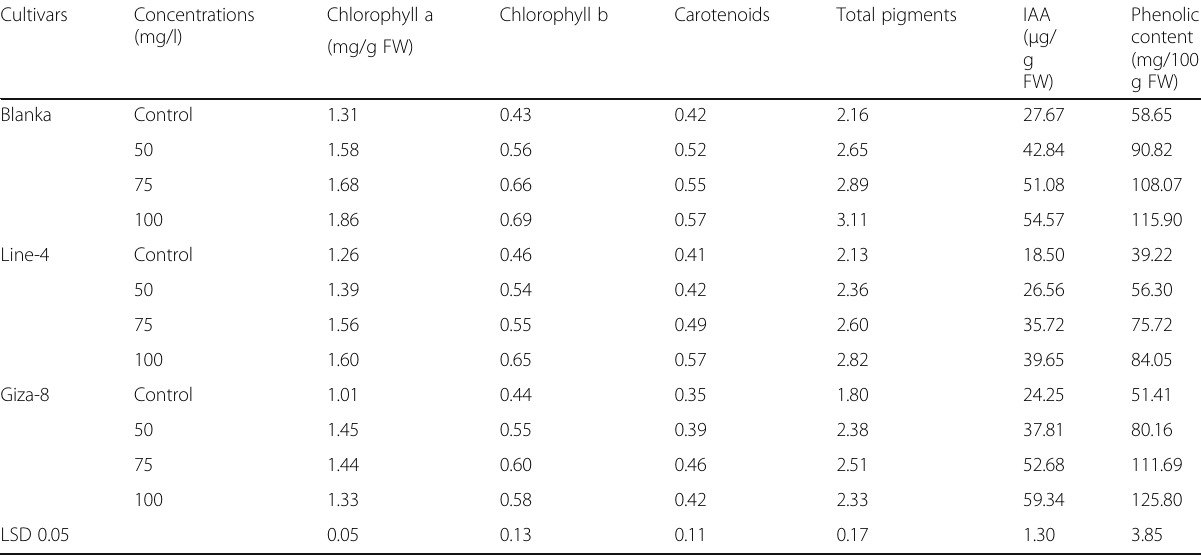
Table 15 Effect of cultivars and phenolic acid concentrations on photosynthetic pigments, IAA, and phenolic content of flax plants grown under sandy soil conditions (data are means of two successive seasons)